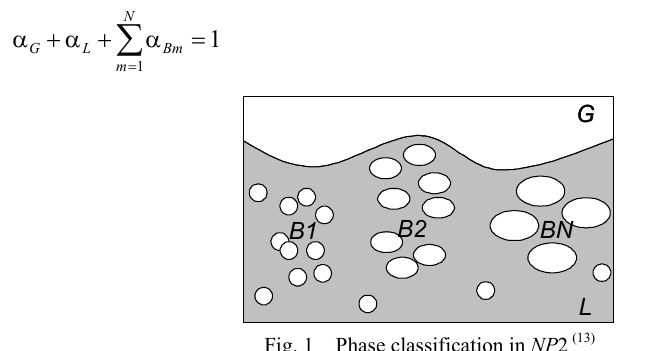
Fig. 1 Phase classification in NP 2